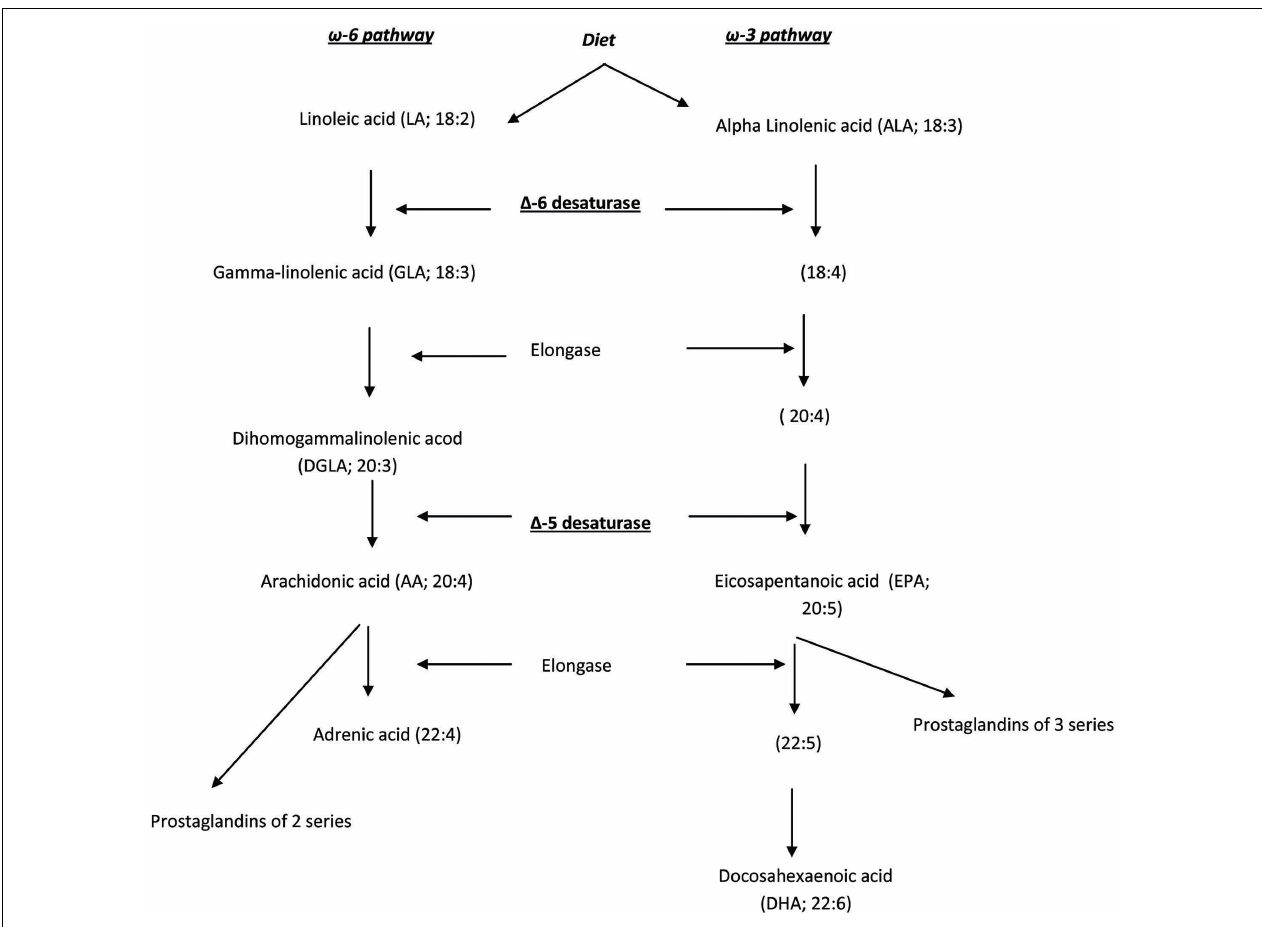
FIGURE 1 | Metabolism of essential fatty